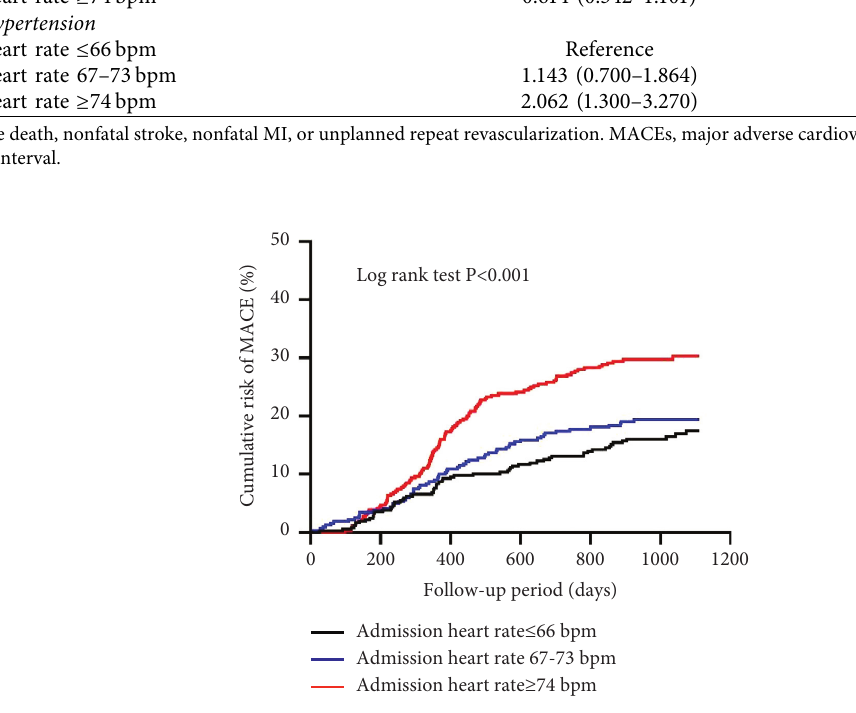
Figure 1: Kaplan–Meier curves of major adverse cardiovascular events stratified by admission heart rate tertiles.